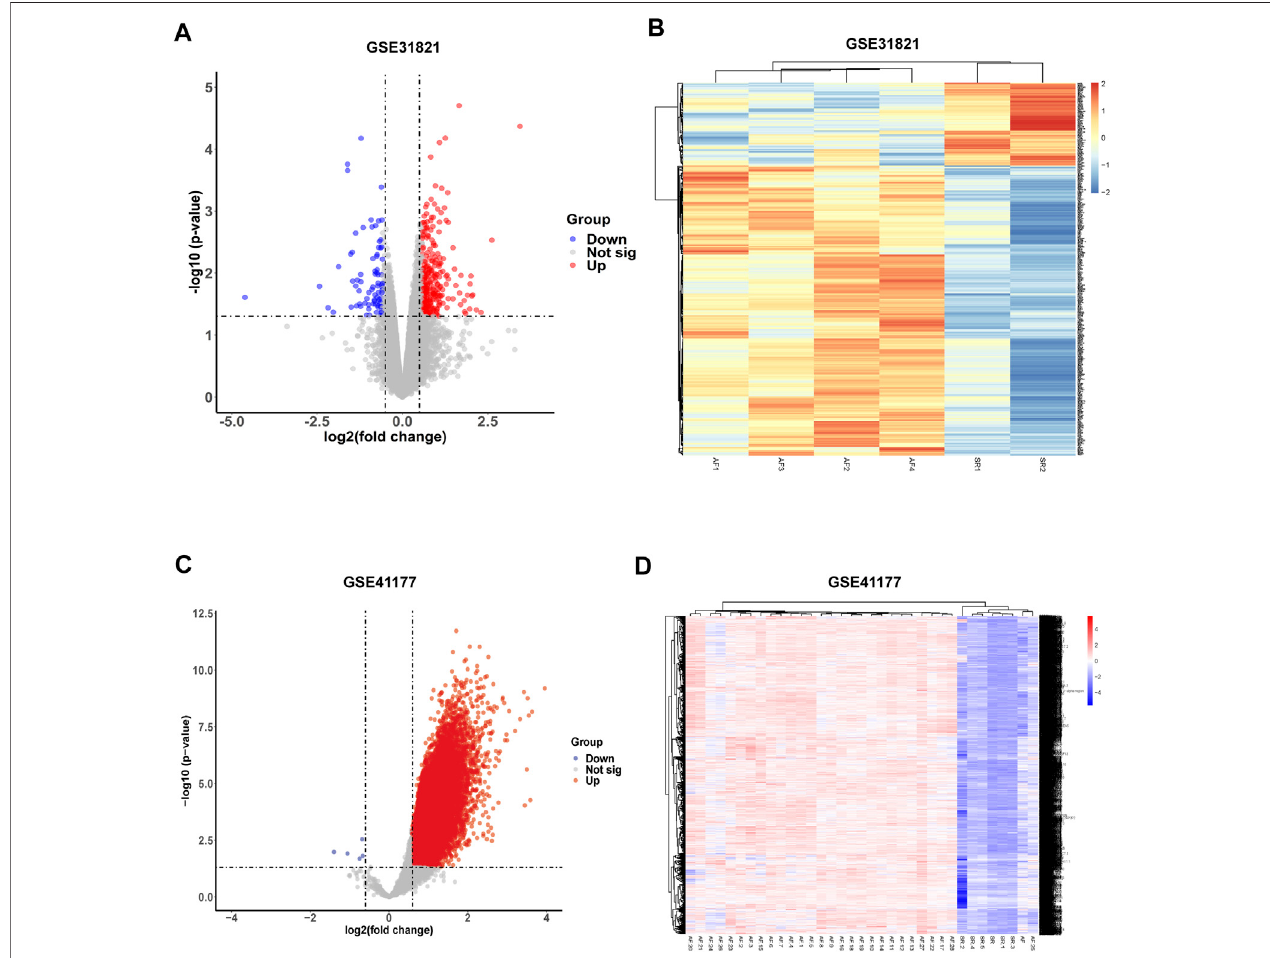
FIGURE 2| Identi fi cation of differentially expressed genes (DEGs) from GSE31821 and GSE 41177 datasets. (A) Volcano plot in GSE 31821. (B) Heatmap in GSE 31821. (C) Volcano plot in GSE 41177. (D) Heatmap in GSE 41177. Blue dots indicate downregulated DEGs while red dots indicate upregulated DEGs. Statistically signi fi cant DEGs were identi fi ed as those with a Student ’ s t -test p -value < 0.05 and |log2(fold-change)| > 0.585.